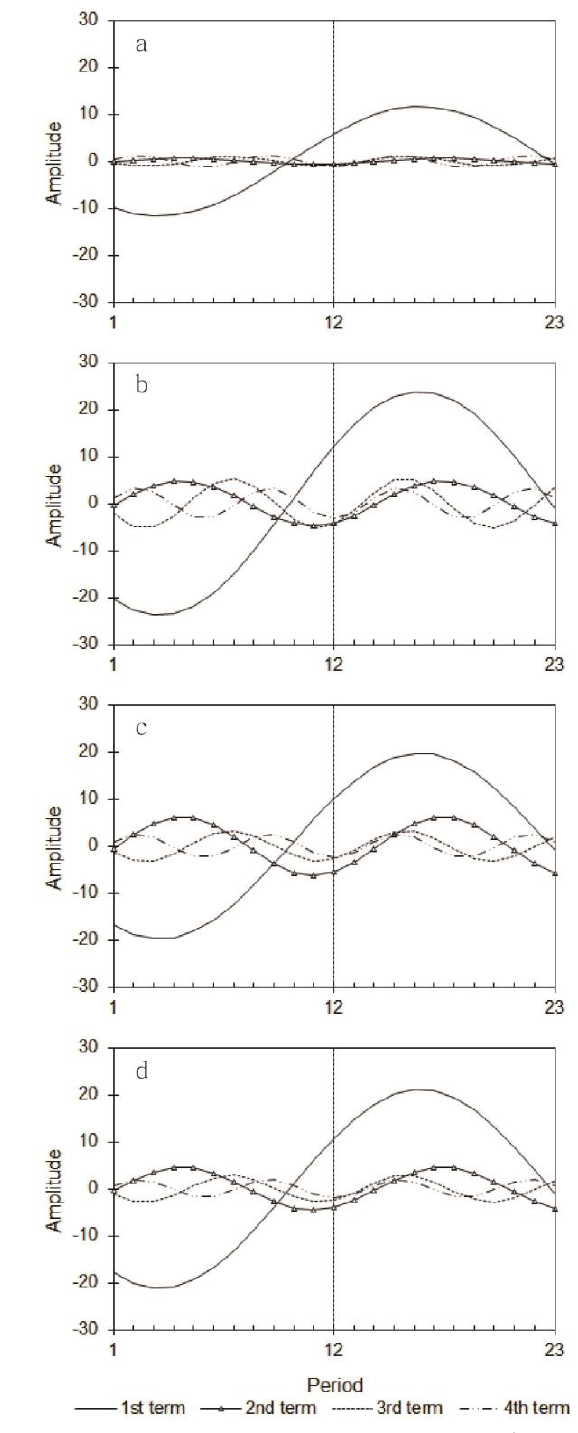
Figure 3. Harmonic patterns for the 4 land cover types (a-mixed forest, b-deciduous forest, c-evergreen forest,